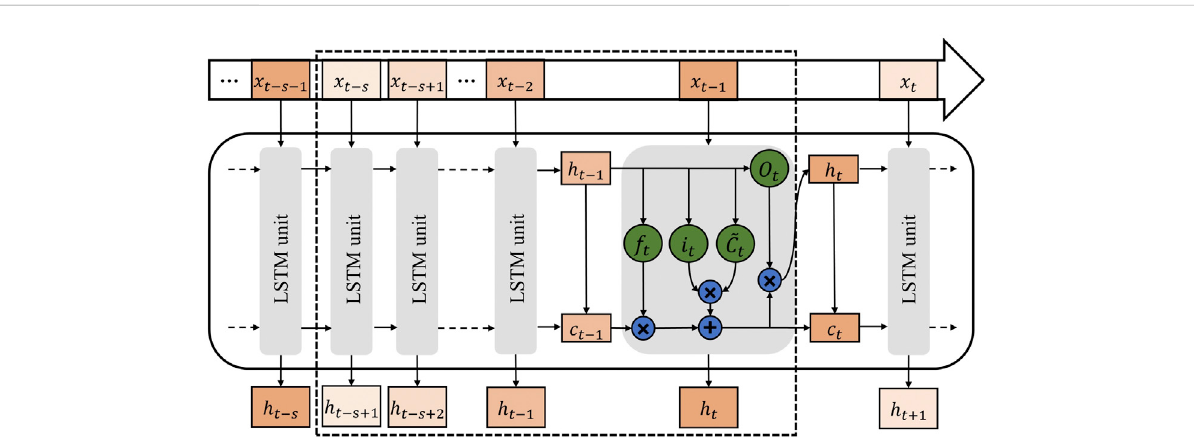
FIGURE 2 Architecture of theLSTM networks used in thisstudy: x t , h t , and C t are the input, output, and cell state at time step t, respectively; sis thelength of input nodes ata time, while inputtingthe sequence x t − s to x t − 1 , themodel outputsthe predicted rainfall h t (at 1 hlead time); f t :forget gate; i t :input gate; ~ C t : cell update; O t : output